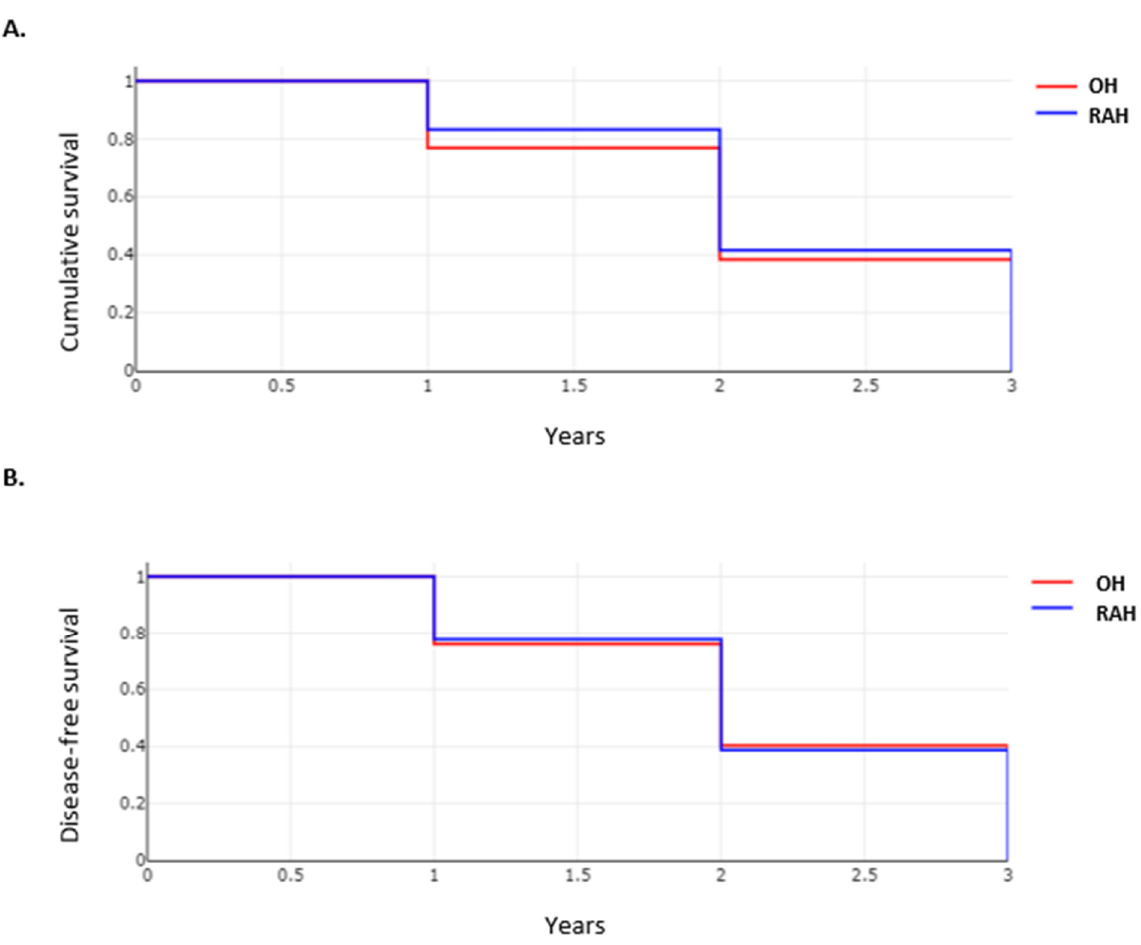
Figure 11. Survivals of patients in OH and RAH groups; ( A ) Overall-survivals of OH and RAH groups; ( B ) Disease-free survival of OH and RAH groups.